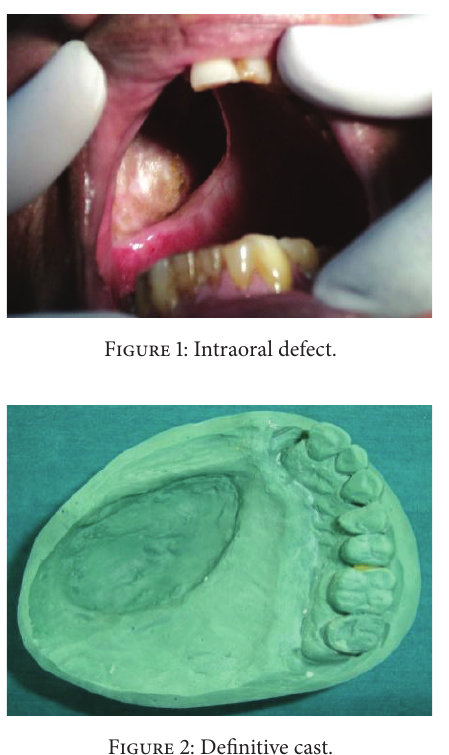
Figure 2: Definitive cast.